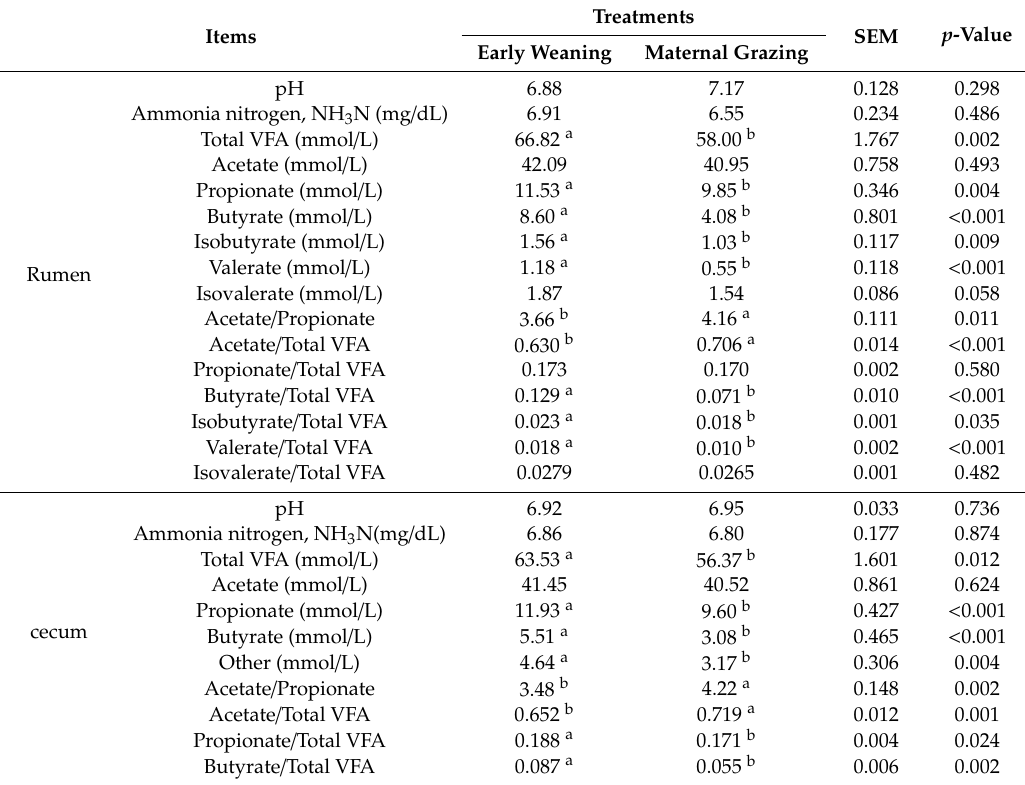
Table 2. E ff ect of early-weaning feeding and maternal grazing feeding on caecal fermentation of yak